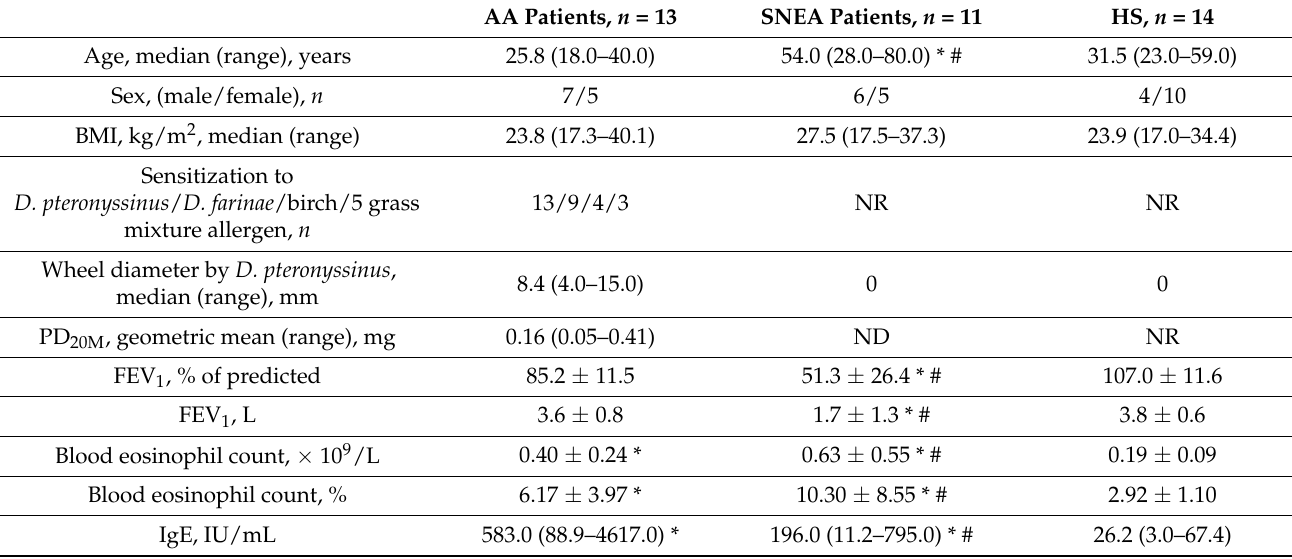
Table 3. Demographic and clinical characteristics of the study population. AA Patients, n =